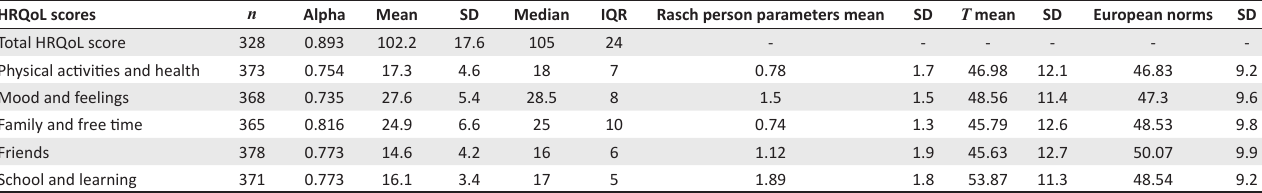
TABLE 5: Health-related quality of life.